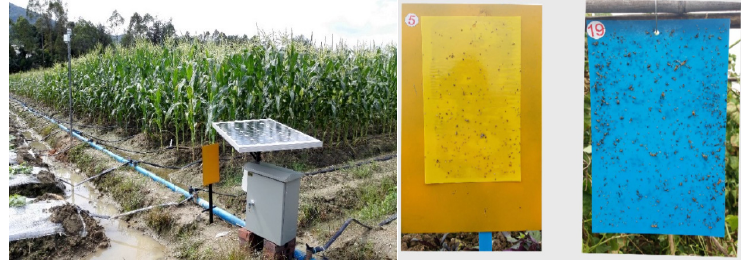
Figure 6. Pests image acquisition equipment.